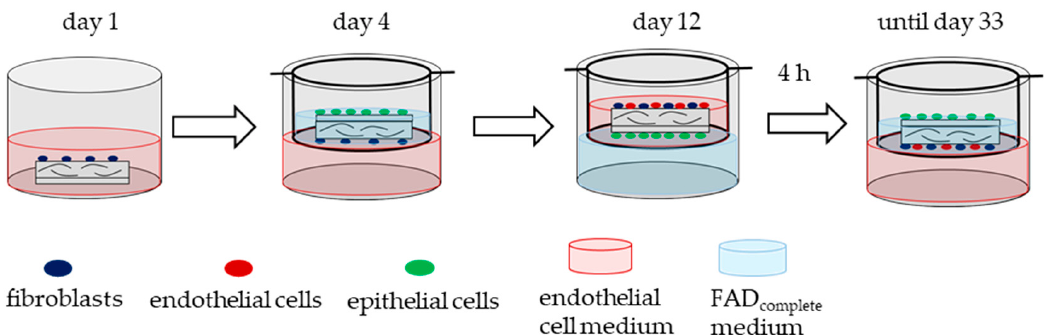
Figure 2. Schematic illustration of the generation of oral mucosa equivalents (tri-culture). Fibroblasts, epithelial cells, and endothelial cells were seeded at different days on a collagen matrix and cultured in a transwell system with two different cell culture media for 33